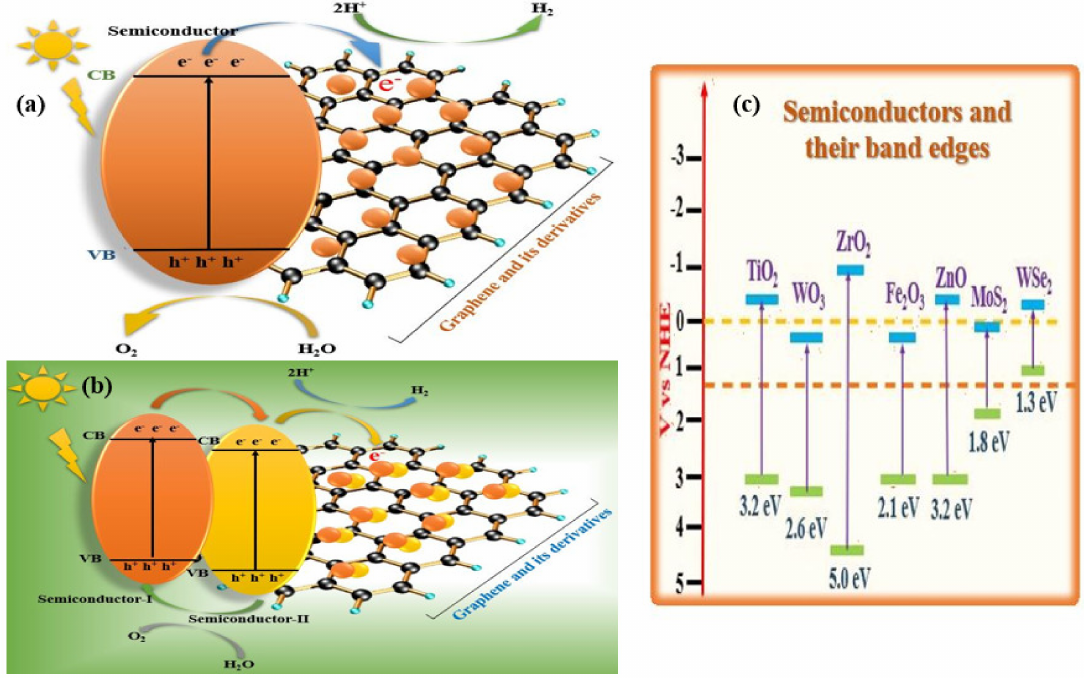
Figure 6. ( a ) Photocatalytic sketch of binary graphene and its derivatives-based composite, ( b ) Photo- catalytic sketch of ternary graphene and its derivatives-based composite and ( c ) Different semicon- ductors with their corresponding band